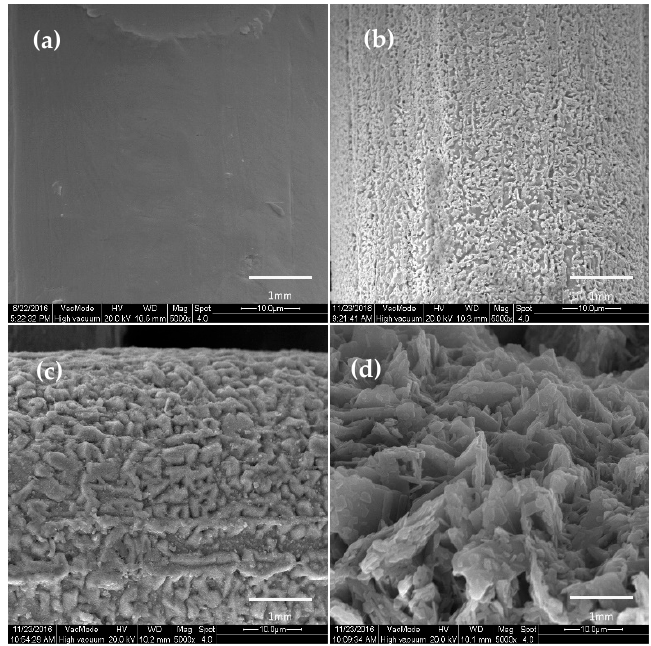
Figure 5. Copper mesh surface morphology. ( a ) Untreated copper mesh; ( b ) Etched copper mesh in FeCl 3 solution; ( c ) Etching and oxidation copper mesh; ( d ) Copper mesh modified with SA.